Question: What does this figure show? Answer in one sentence.
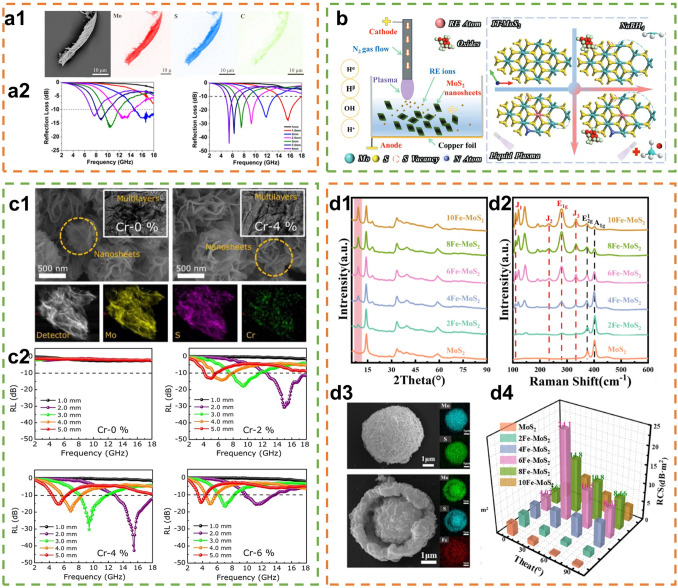
Answer: a1 SEM image and corresponding EDS mappings of C-doped MoS 2 -1.5; a2 RL curves of C-doped MoS 2 -0.5, 1.0, 1.5 respectively [ 125 ]. Copyright 2020 American Chemical Society. b Graphical summary illustrating the synthesis and system configuration for liquid plasma production, and the consequent phase transformation in the microstructure of IT-MoS 2 post NaBH 4 and liquid plasma treatment [ 34 ]. Copyright 2024 Wiley-VCH. c1 SEM images of MoS 2 , Cr-4% doped MoS 2 nanosheets and EDS mappings of Cr-4% doped MoS 2 ; c2 RL curves of Cr-0%, 2%, 4%, 6% doped MoS 2 respectively [ 126 ]. Copyright 2018 Springer Nature. d1 XRD patterns and d2 Raman spectra of Fe doped MoS 2 samples; d3 SEM images and corresponding EDS mappings of MoS 2 and 8Fe-MoS 2 yolk-shell microspheres respectively; d4 The RCS value reduction of the Fe doped MoS 2 samples [ 127 ]. Copyright 2025 Elsevier